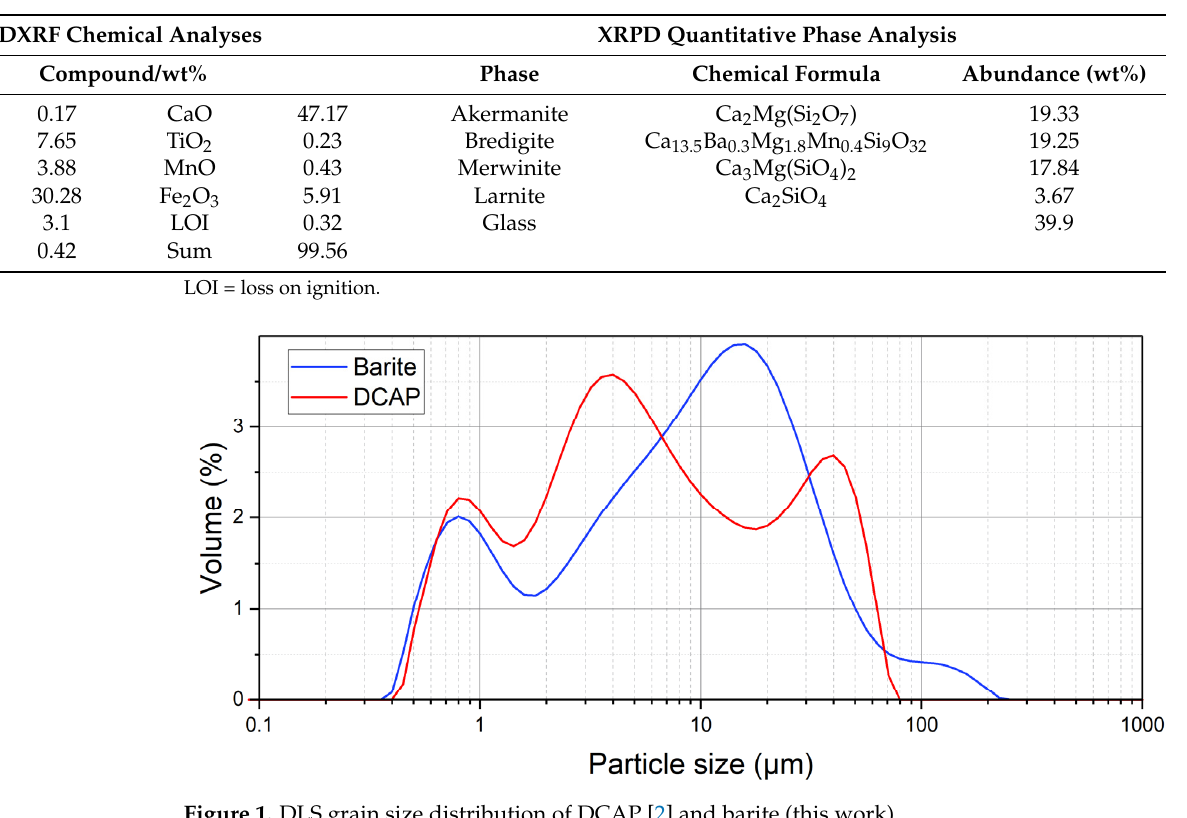
Table 3. Results of mechanical tests (compressive, tensile, and flexural strength) for the PF samples. Compressive